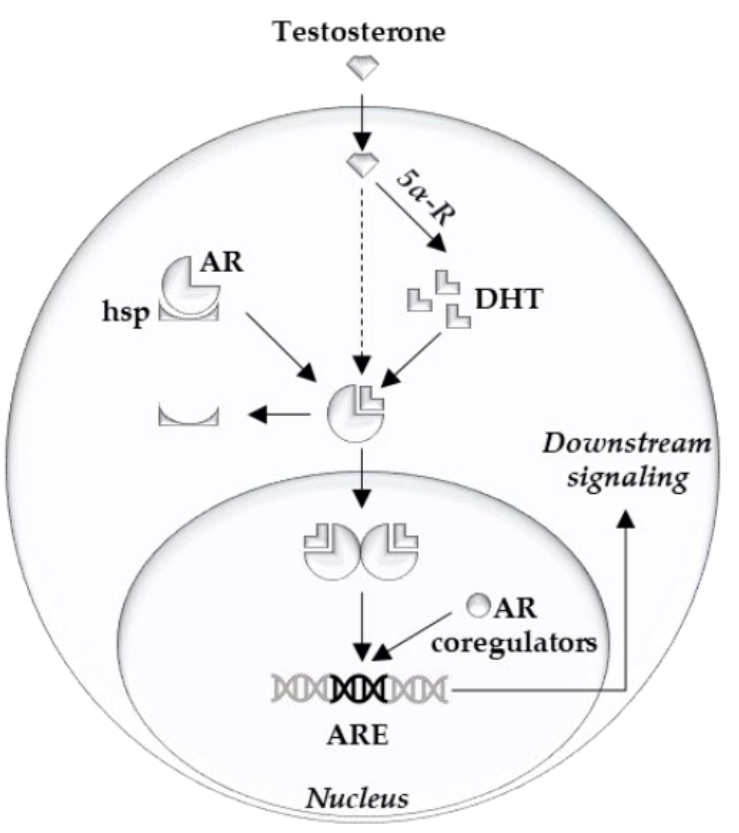
Figure 1. Overview of intracellular androgen action. Androgen receptor (AR), heat shock proteins (hsp), dihydrotestosterone (DHT), 5-alpha reductase (5 α -R), androgen response element (ARE).